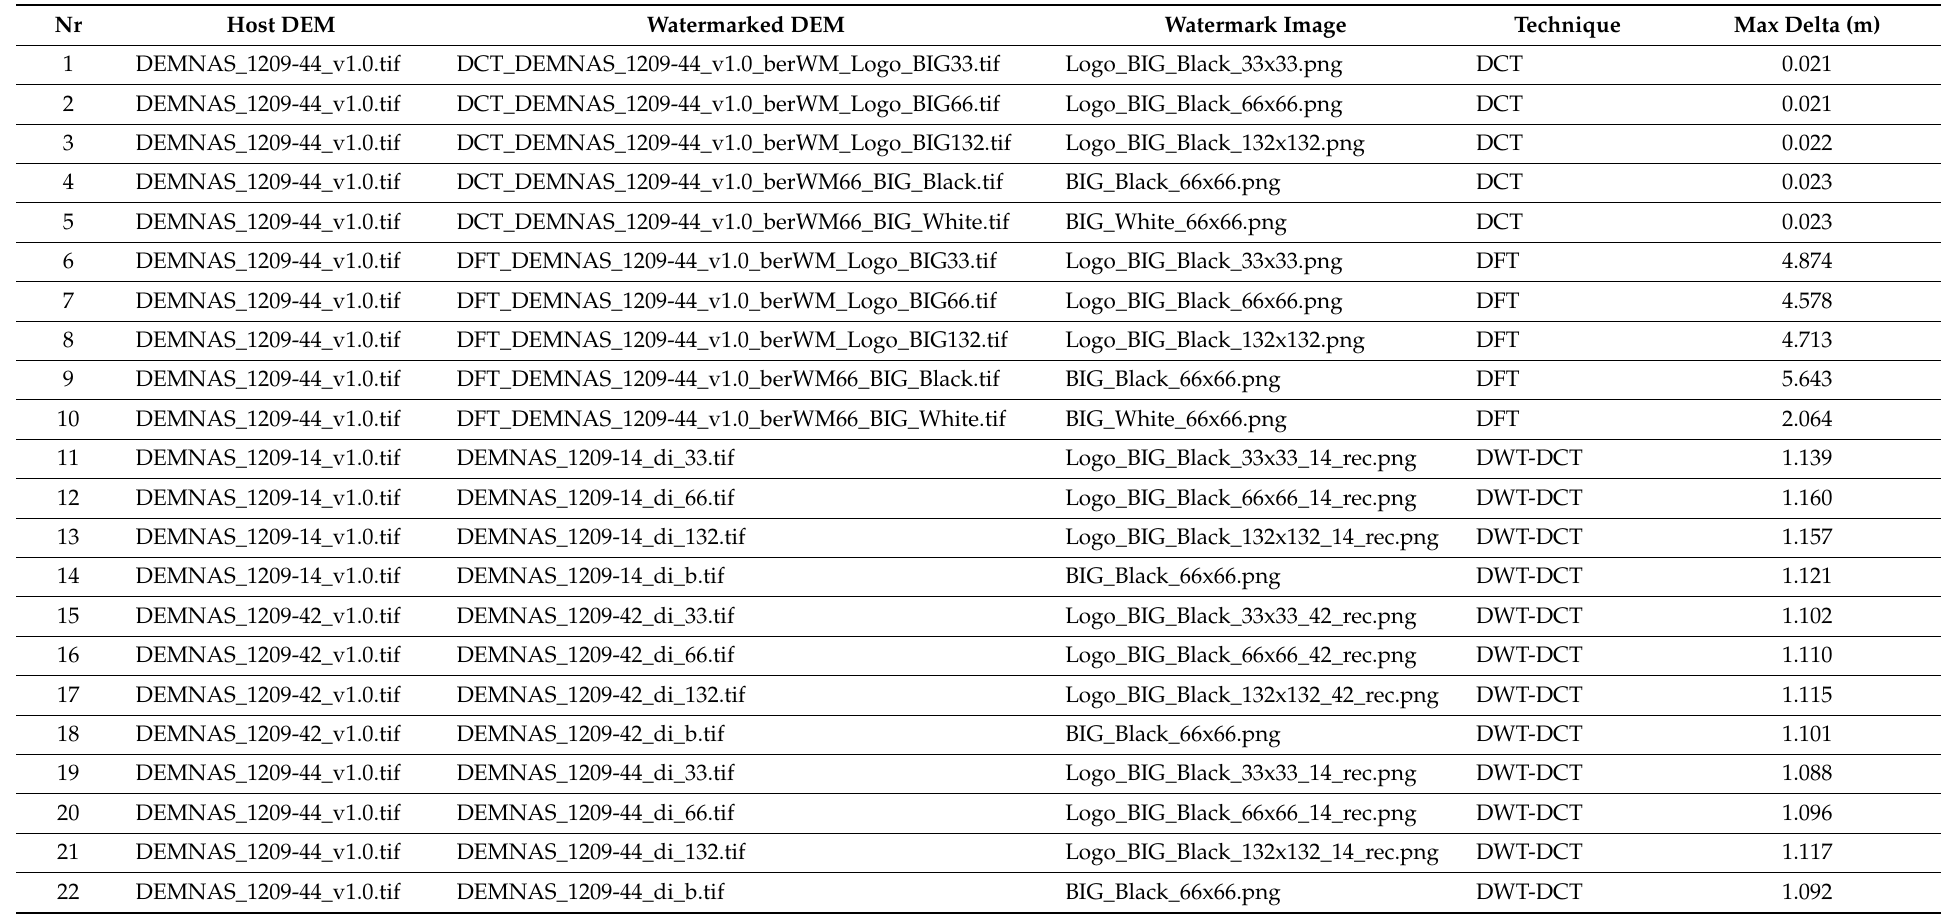
Table 8. Experimental results of the evaluation parameter of Max